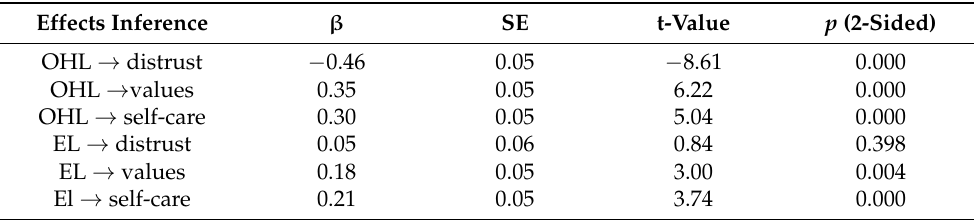
Table 5. The inference of the effects of knowledge on values, attitudes, and behaviours on oral health; male sample (N = 250).